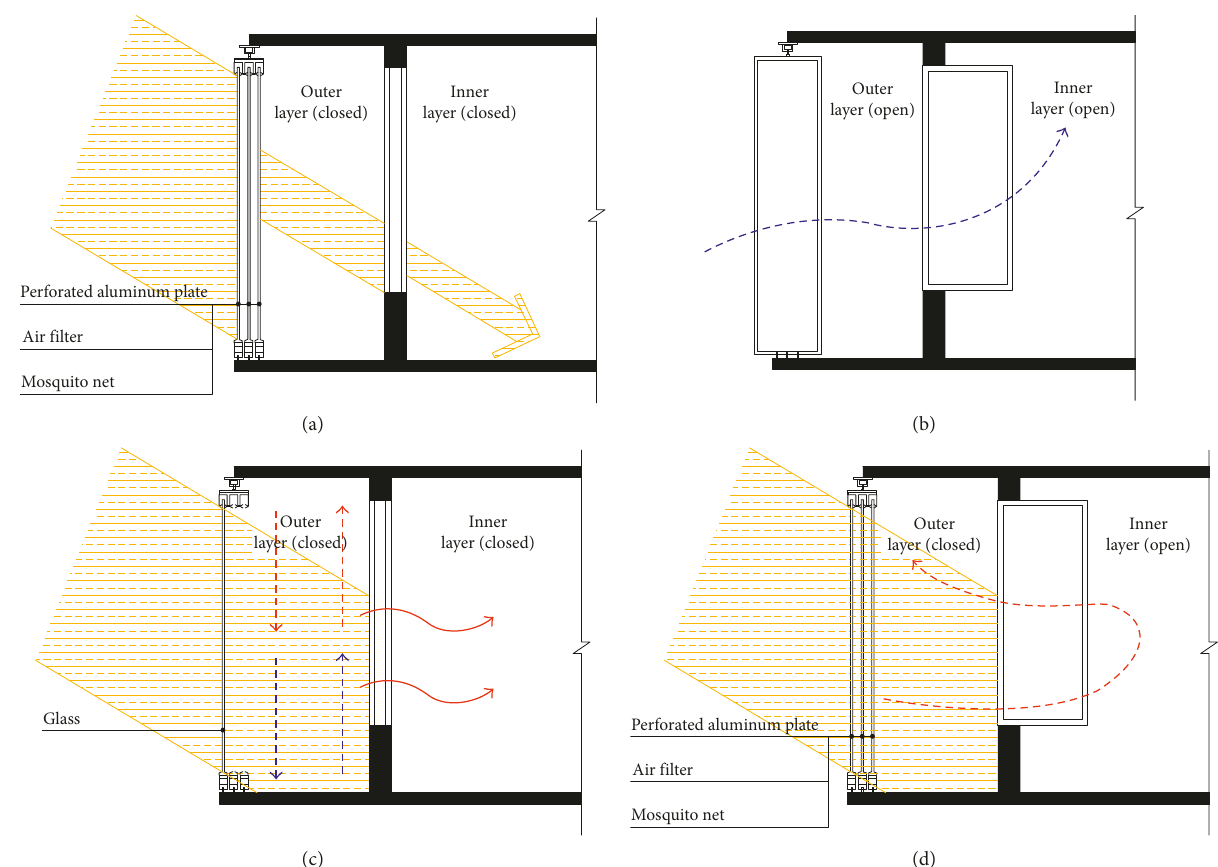
Figure 17: The climate adaptation mode of the integrated changeable modules throughout the building’s entire life cycle (source: authors’ own data). (a) Shading/air filter mode (summer day); (b) natural ventilation mode (summer night); (c) sunspace mode (winter day); (d) sunspace/air filter mode (spring and autumn